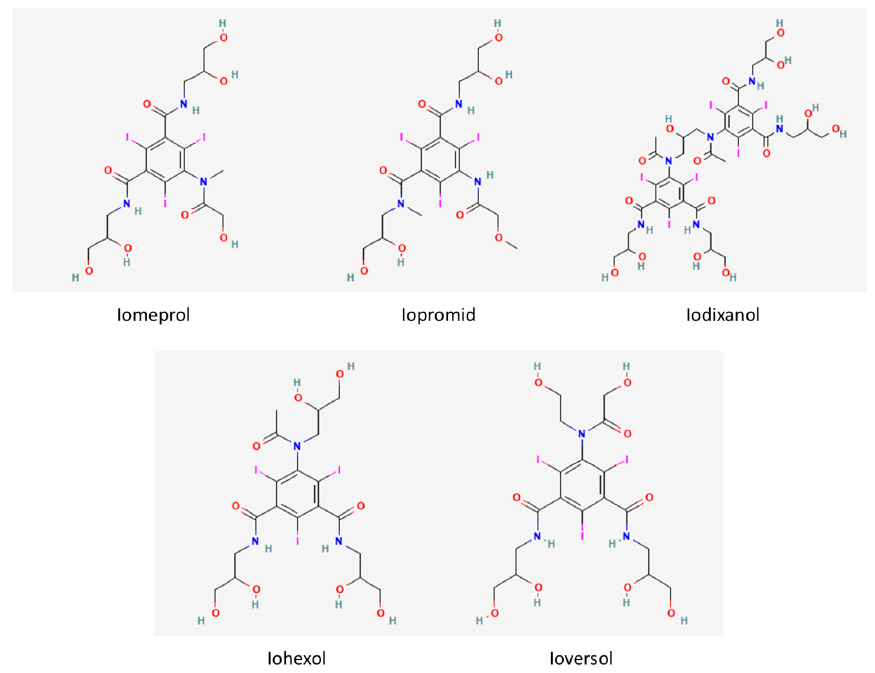
Figure 1. Iodine-based contrast media.